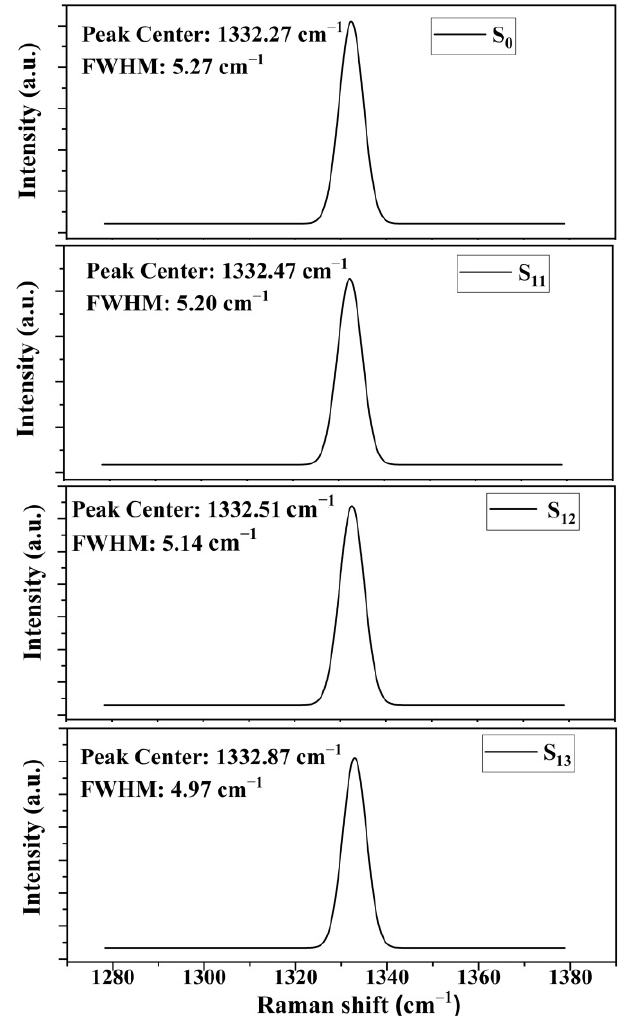
Figure 5. The variation of Raman spectroscopy extracted from S 0 , S 11 , S 12 , and S 13.